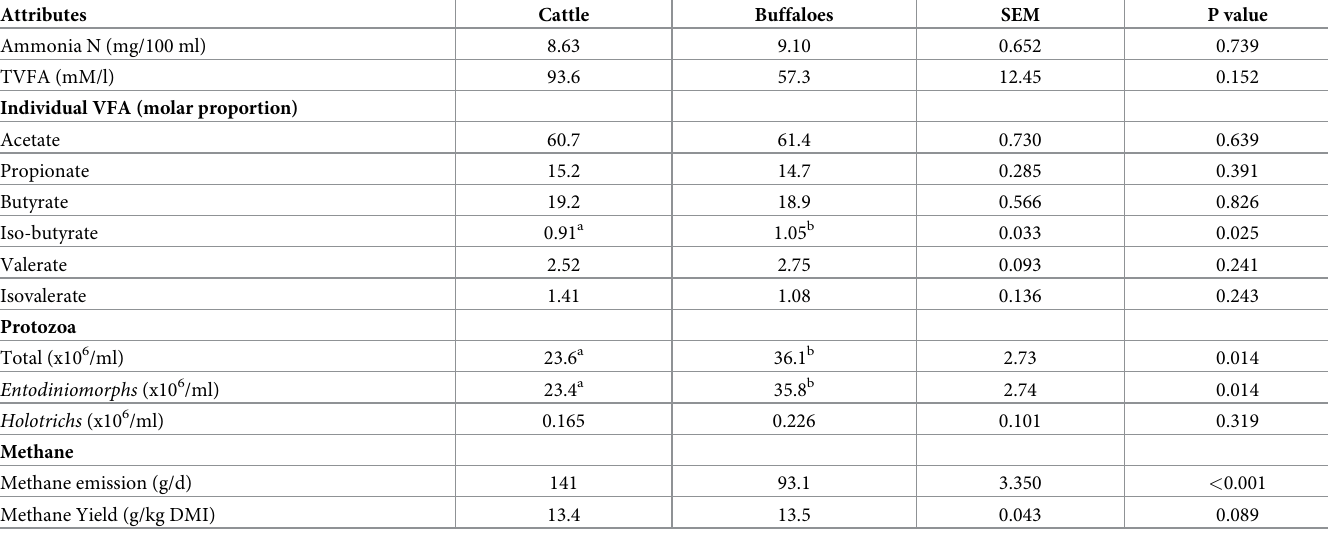
Table 1. Comparison of ruminal methanogenesis and mean concentrations of ammonia and total volatile fatty acids as well as molar proportions of principal vola- tile fatty acids in ruminal fluid of cattle and buffaloes.